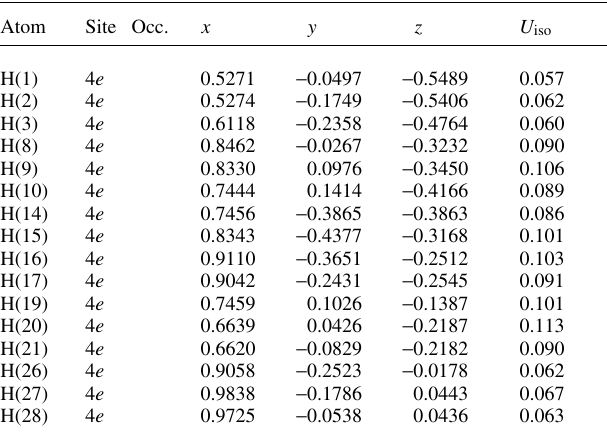
Table 2. Atomic coordinates and displacement parameters (in Å 2 )